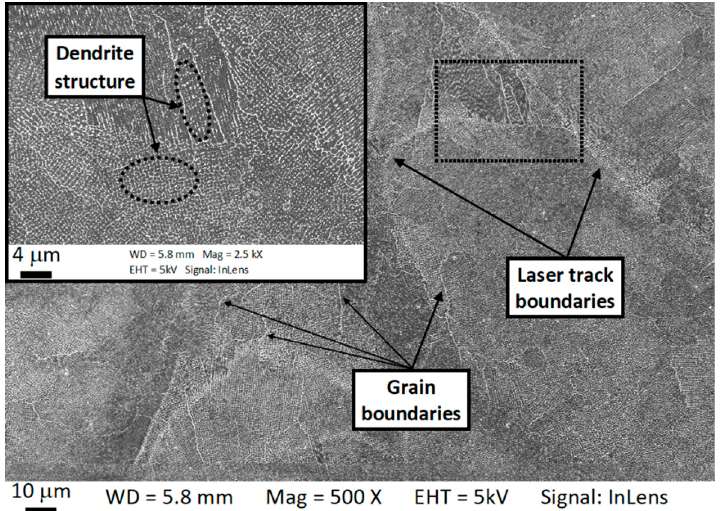
Figure 10. Scanning electron microscopy (SEM) micrographs of the horizontal plane showing laser tracks, grains and the subgranular dendrite structures.